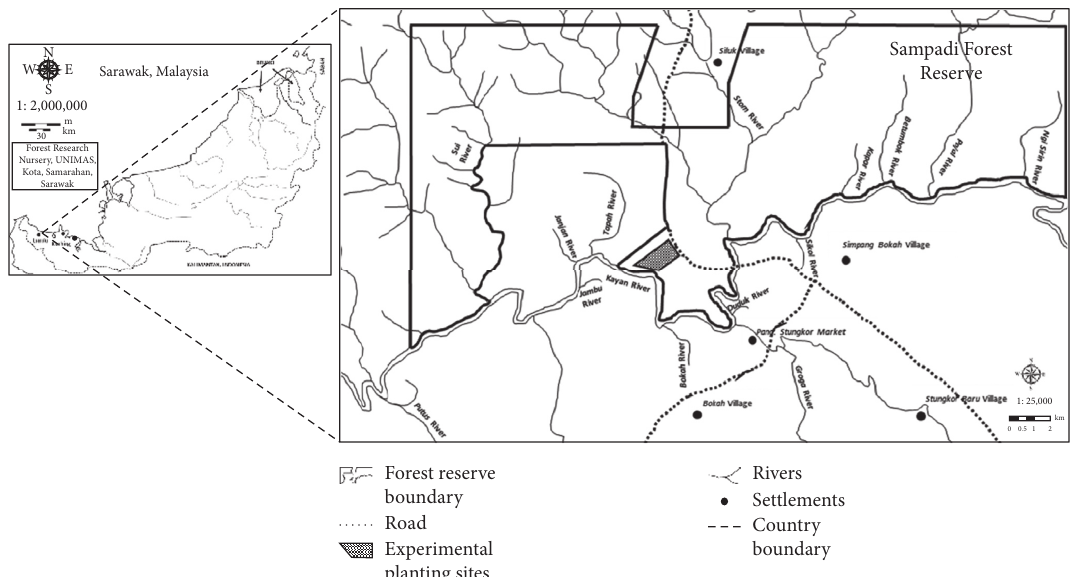
Figure 1: Location of the study area: Sampadi Forest Reserve Experimental Planting Sites. Perumal et al.; Mohamad Jaffar et al.; Department of Agriculture, Sarawak, Malaysia [19, 20, 27,